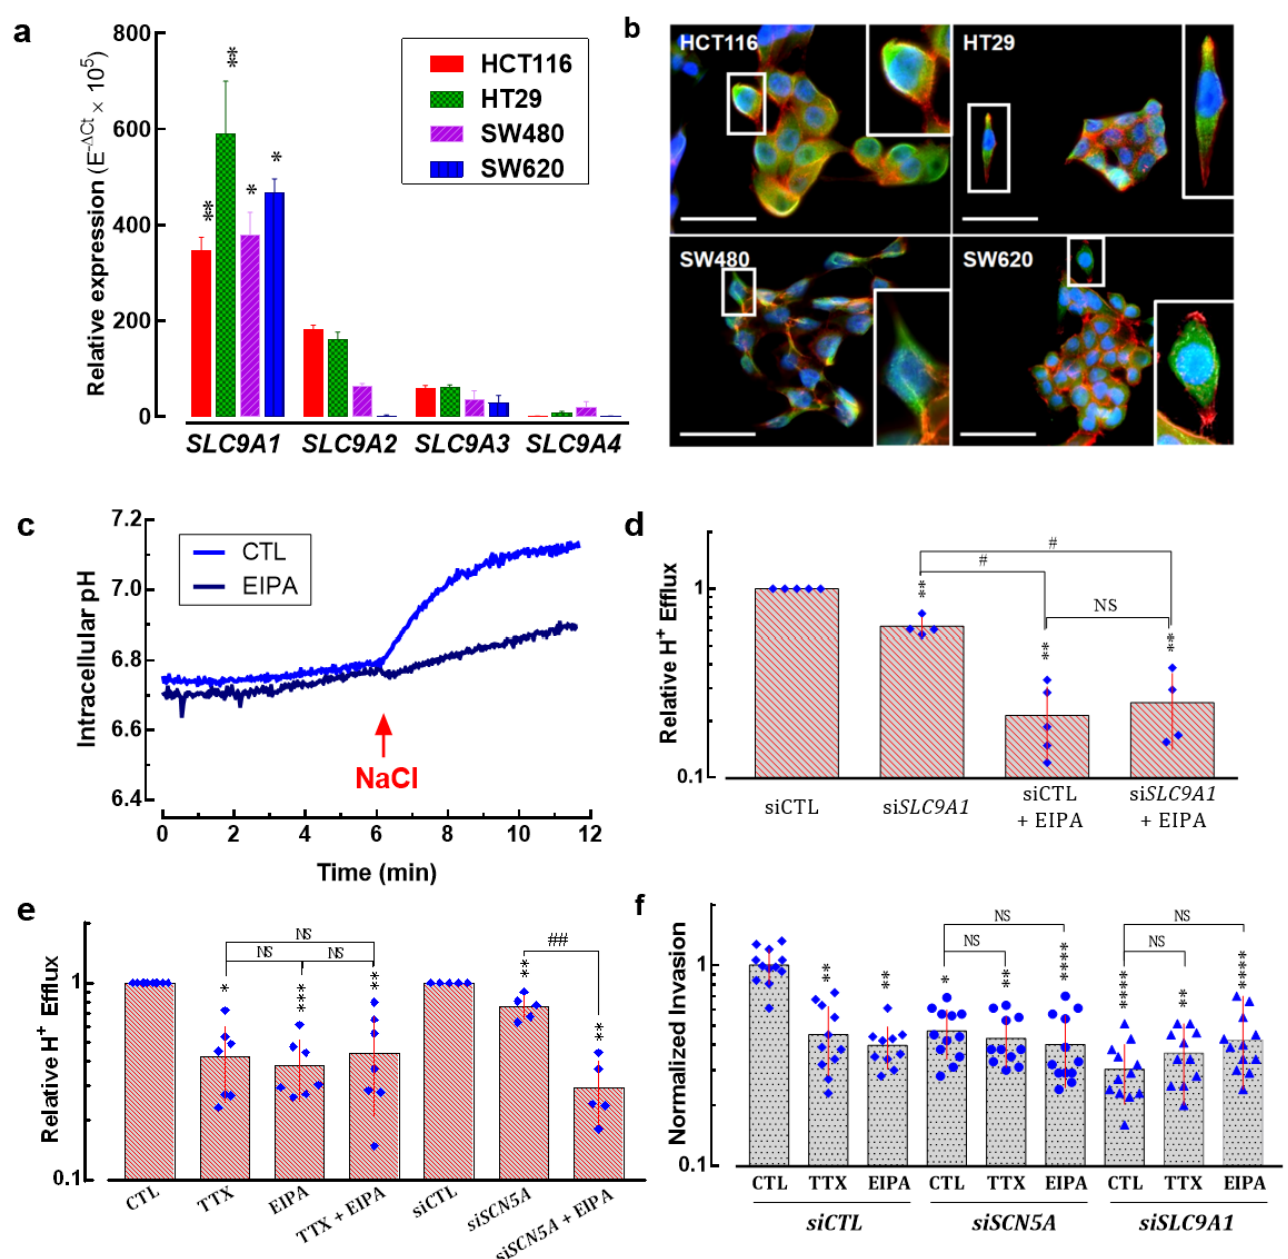
Figure 6. Sodium/hydrogen exchanger type-1 contributes together with Na V 1.5 channels to colon cancer cell invasiveness. ( a ) Bars represent the relative expression (10 −ΔCt × 10 5 ) of sodium/hydrogen exchanger family gene members ( SLC9A1 - SLC9A4 ) in HCT116, HT29, SW480 and SW620 colorectal cancer cells. The SLC9A1 gene (encoding for NHE-1) was the most expressed isoform in these cell lines ( n = 6). ( b ) Epifluorescence microscopy analysis of the NHE-1 protein in HCT116, HT29, SW480 and SW620 cells. Images show the staining for the NHE-1 protein (green, AlexFluo488), F-actin filaments (red, phalloidin-594) and nuclei (blue, DAPI). NHE-1 protein is mainly located at the plasma membrane of cancer cells. A threefold digital amplification was performed for the cell framed within the white box and shown on the right side of each image. Scale bar 50 µm. ( c ) Representative intra- cellular pH evolution in NH 4 Cl-acidified SW620 cells resuspended in 130 mM NaCl in the presence of 30 µM TTX or 10 µM EIPA or under control condition. ( d ) Plot shows relative H + efflux measure- ments after NH 4 Cl-induced intracellular acidification of SW620 cells transfected with siCTL or siSLC9A1 in the absence or presence of 10 µM EIPA ( n = 5) ** p < 0.01 vs. siCTL; # p < 0.05 vs. siSLC9A1 ; NS stands for not statistically different. € Relative H + efflux of SW620 cells under control condition or transfected with siCTL or siSCN5A in the absence or presence of 30 µM TTX or 10 µM EIPA ( n =